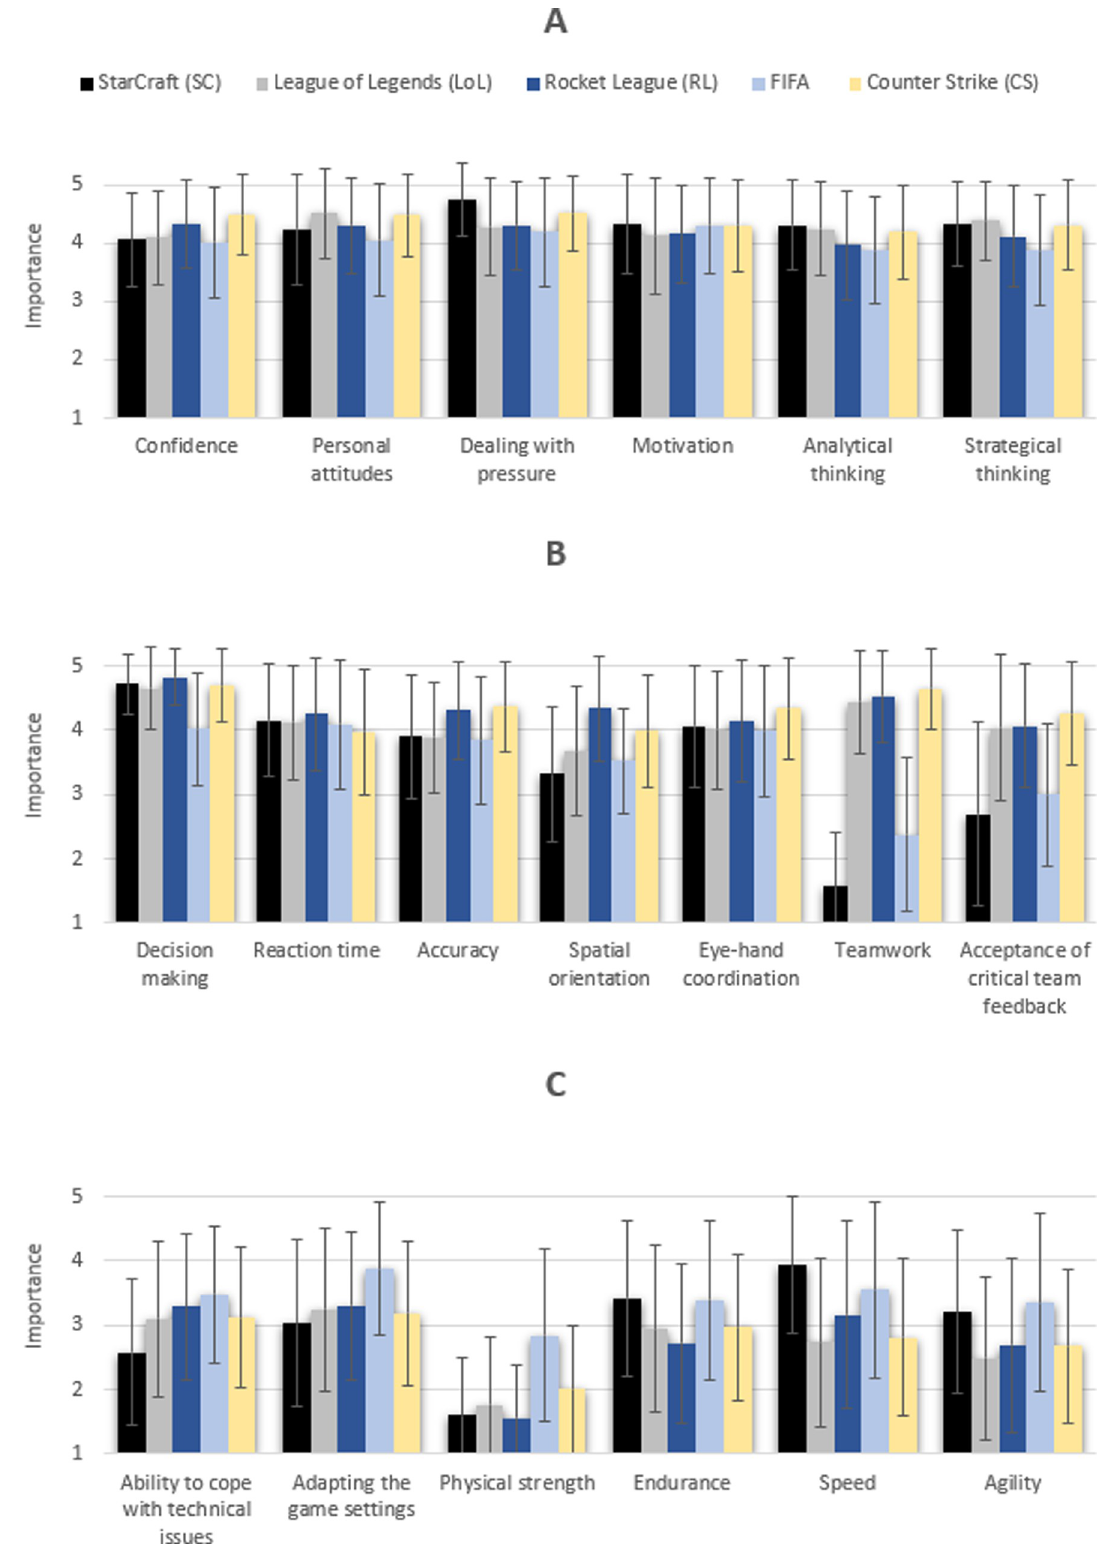
Fig 12. Importance of 19 competencies (means and SD). Scale: 1 –not important at all; 3 –somewhat important; 5 –very important.